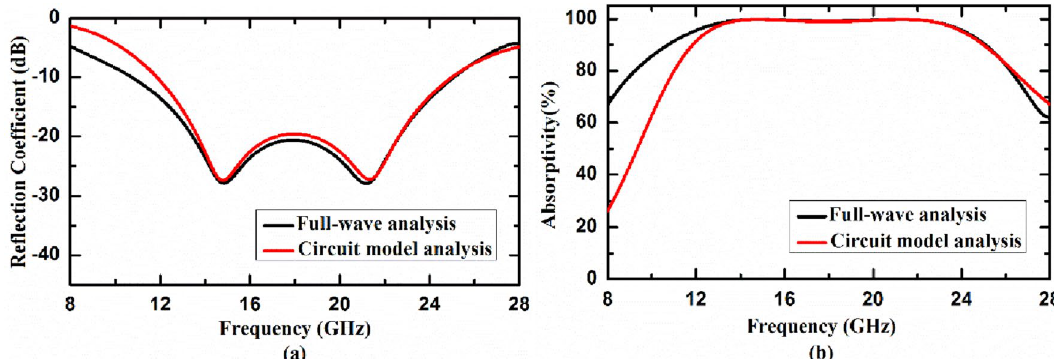
Figure 2. ( a ) Reflection coefficient and ( b ) absorptivity of the proposed metasurface absorber calculated using equivalent circuit model analysis and full-wave simulation using CST MICROWAVE